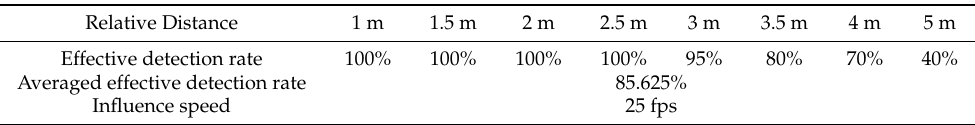
Table 2. Object detection results.